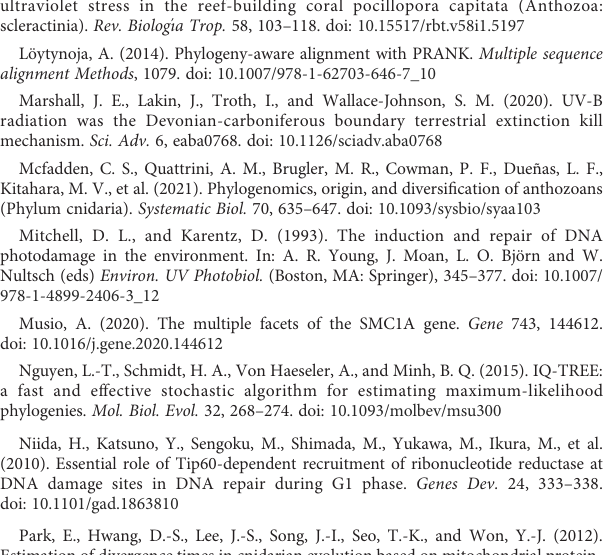
SUPPLEMENTARY TABLE 4 Amino acid changes shared by living stony corals for PSGs.